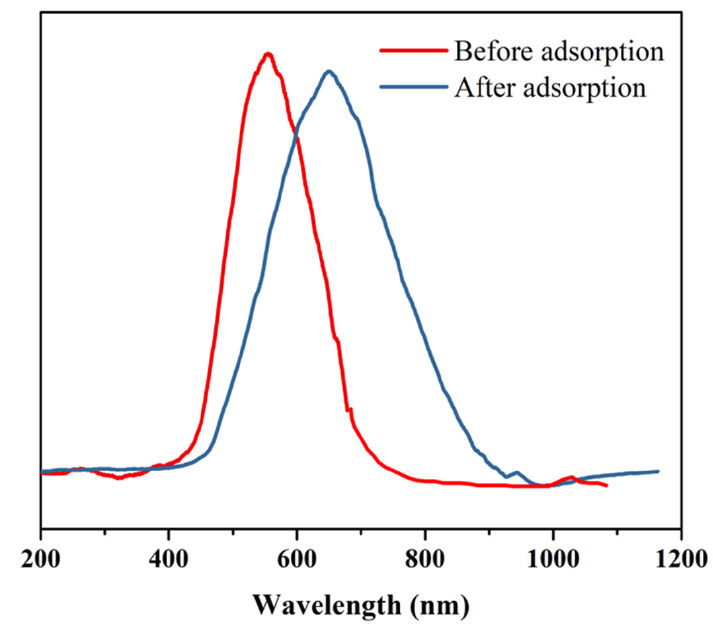
Figure 7. VPA-hydrogel reflection spectrum before and after adsorption.